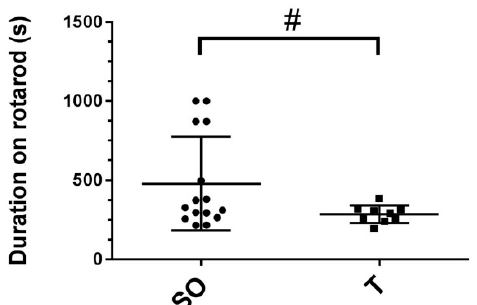
Figure 2. Rota-rod exercise times trended toward shorter duration in PNA compared with control rats. At 15 weeks of age, female rats that were prenatally exposed to sesame oil (SO, n = 15) or testosterone (T, n = 9) were placed on a rota-rod that gradually accelerated to a maximum speed of 40 rpm. The time spent on the rota-rod before falling off was recorded, with a maximum possible time of 1000 s. Each rat underwent a timed trial once daily for three consecutive days. Data were analyzed using unpaired t-tests and trended toward shorter duration for PNA rats (# p = 0.0684). Values are the means ± SD.